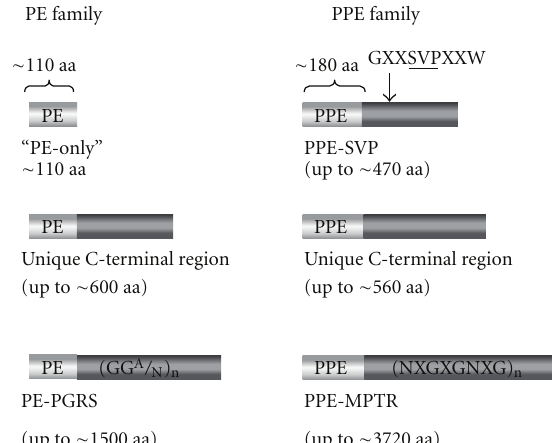
Figure 1: Schematic representation of PE and PPE family sub- groups. PE and PPE proteins possess relatively conserved N- terminal domains of approximately 110 aa and 180 aa, respectively. One subgroup of the PPE family incorporates a characteristic “SVP” motif at approximately 350 aa. Both PE and PPE families can be divided into distinct subgroups on the basis of their variable C- terminal domains. The regions encoded by the Polymorphic GC- Rich Sequence (PGRS) of the pe family and the Major Polymorphic Tandem Repeats (MPTR) of the ppe family are major contributors to genome